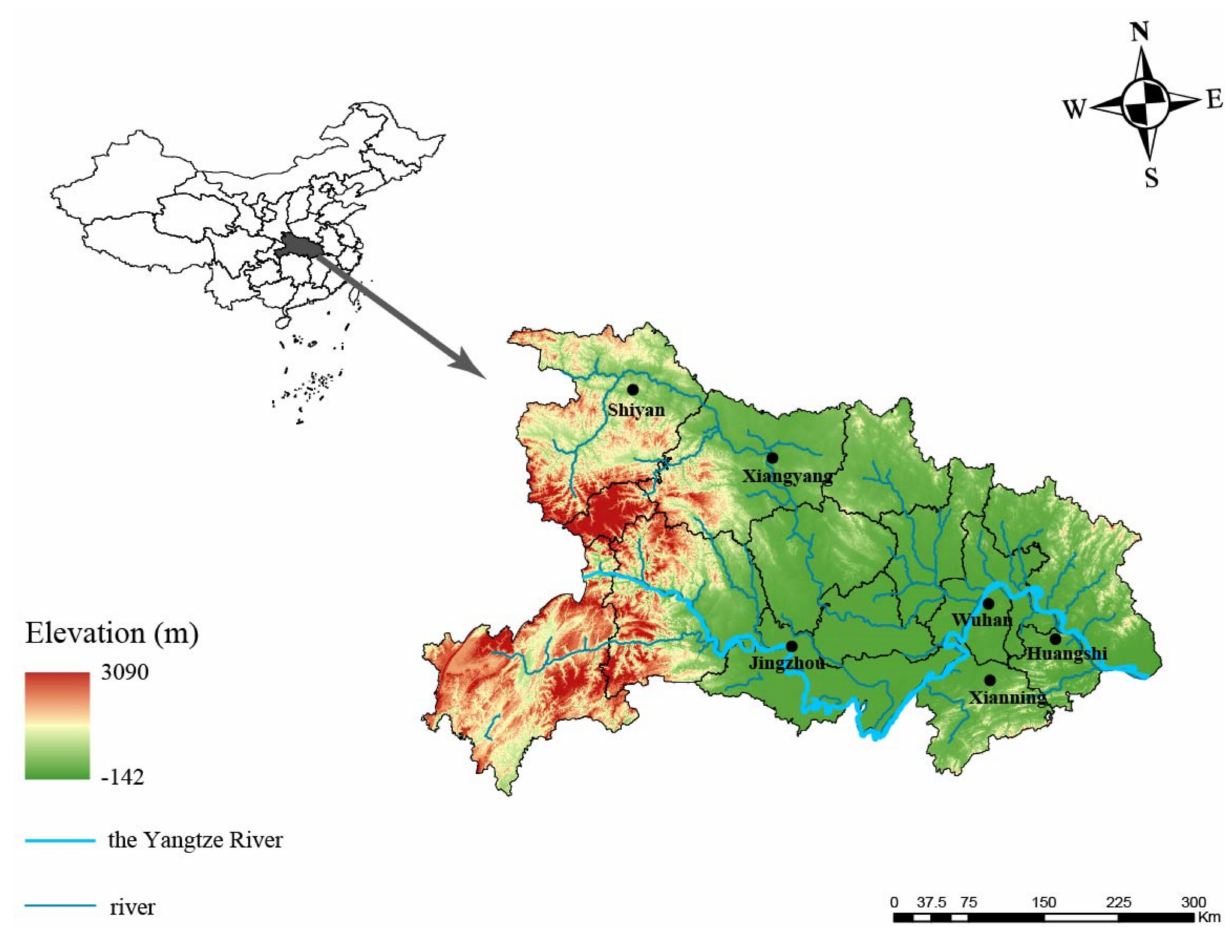
Figure 1. Geographic map showing the location of sampling sites. Samples collected from six cities of Hubei Province are shown using circles. The map was created in ArcGIS 10.8 software (ESRI Inc., Redlands, CA, USA) and Adobe illustrator, Version CC2018 (Adobe, San Jose, CA, USA). The black dots indicate the sampling regions in this